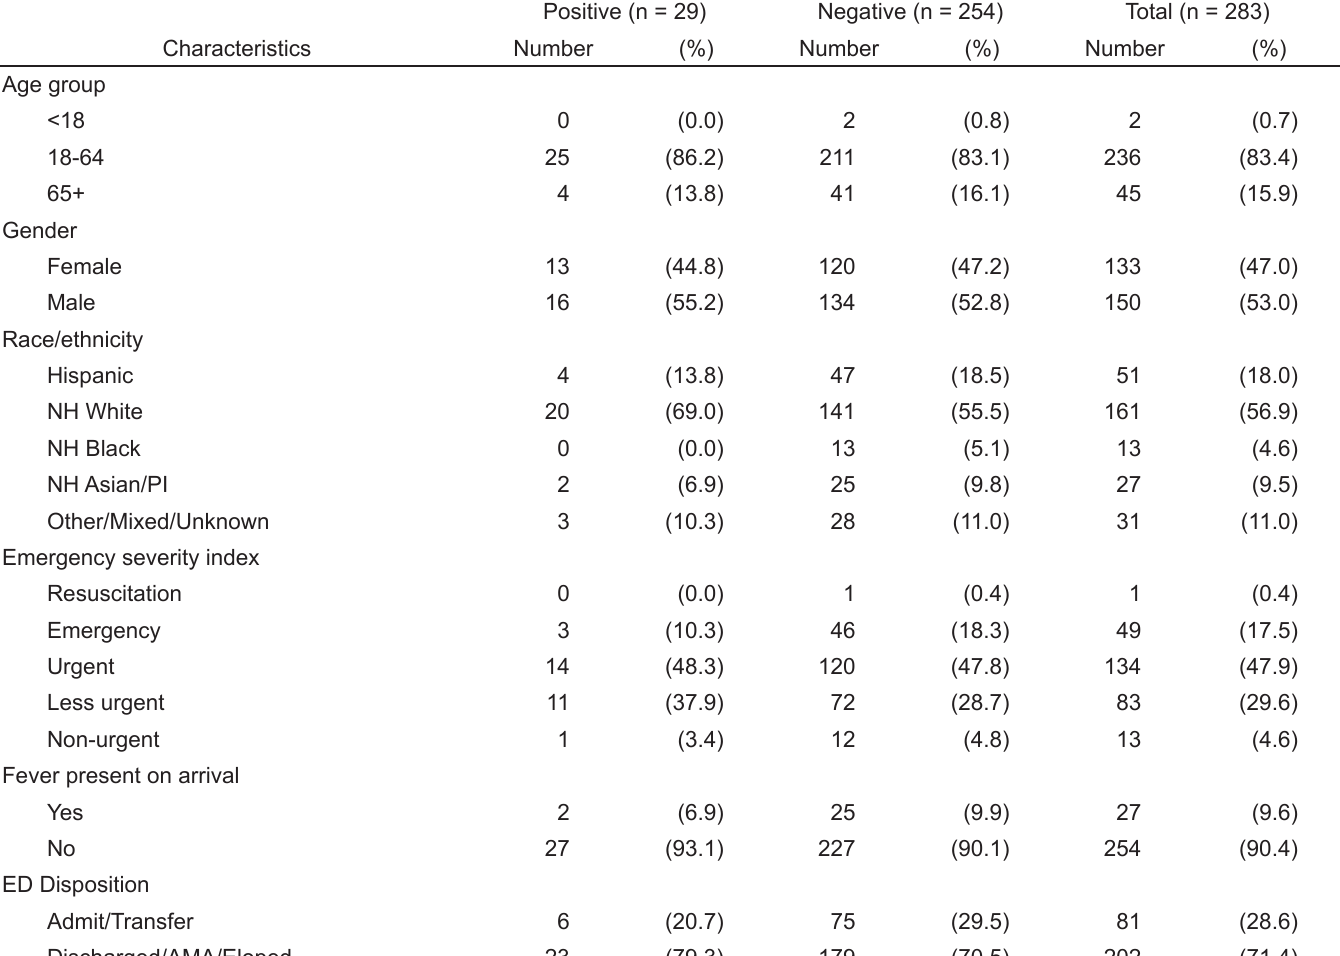
Table 1 . Patient demographics and clinical characteristics by test results for patients who were tested for COVID-19 during the first 10 days of